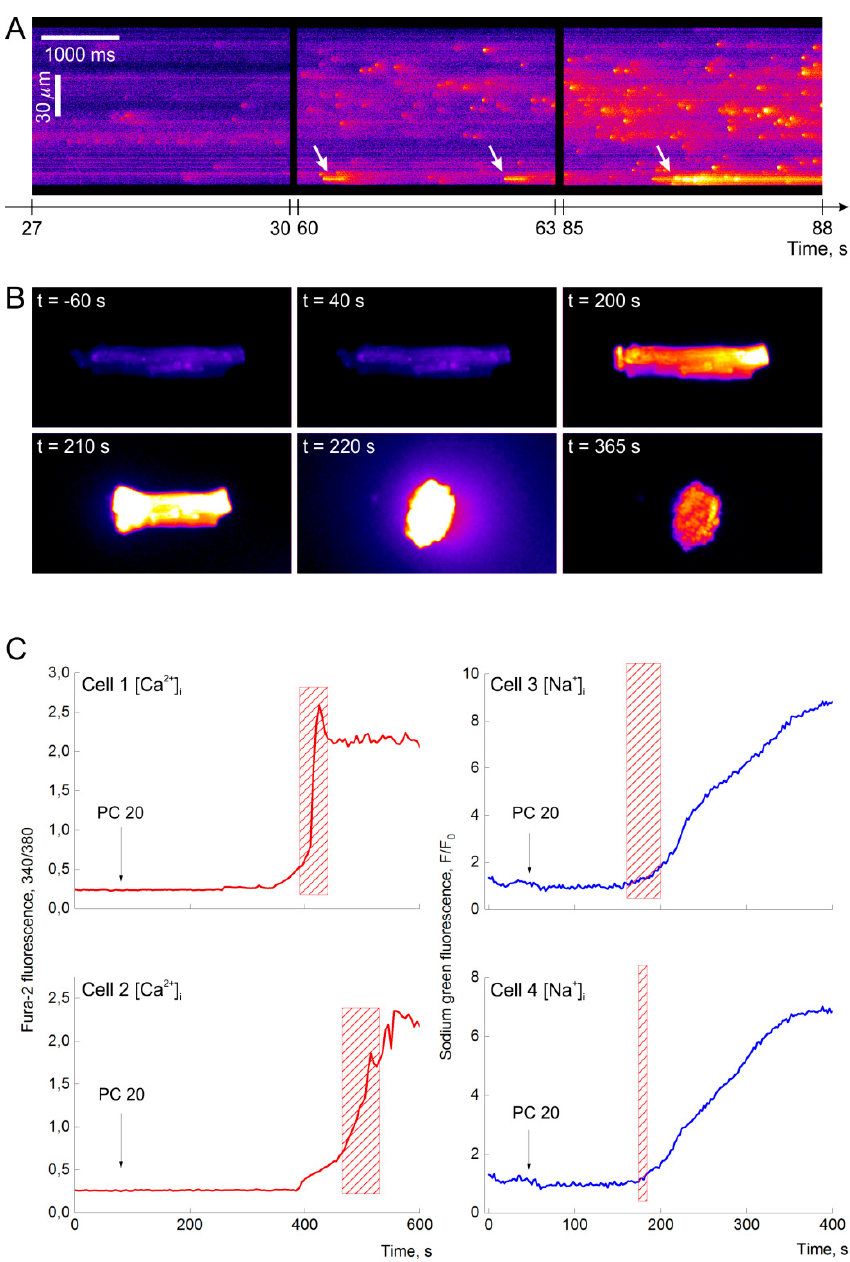
Figure 1. Concentration-dependent effects of PC and MC: Ca 2+ -sparks and Ca 2+ -enriched microdomains, Ca 2+ overload and CM death. Steep rise in [Ca 2+ ] i precedes [Na + ] i increase. ( A ). At low concentration of 5 µM, myristoyl-L-carnitine (MC) induces Ca 2+ -sparks, short and long time living steady state regimes with high [Ca 2+ ] i in isolated microdomains marked by arrows. Confocal images of CM stained with Fluo-4 in XT mode, 27 s (left) and 88 s (right) after the addition of 5 µM MC. Horizontal axis—time; vertical axis—the long axis of the cardiomyocyte. ( B ). At high concentration palmitoyl-L-carnitine (PC, 20 µM) evokes after time delay of approx. 200 s: initial rise of Ca 2+ in limited compartment of the cell (bright spot at right side of cell, t = 200 s), Ca 2+ overload (bright rod shape cell, t = 210 s), hypercontracture and rupture of plasma membrane characterized by fluorescent dye loss (bright oval cell, t = 220 s), and cell death (red oval cell, t = 365). In 700 and 710 s images the fluorescent probe is seen to escape from the cell into the extracellular solution, leading to decrease in signal intensity. ( C ). Steep rise in [Ca 2+ ] i precedes hypercontracture development, while the increment of [Na + ] i follows it. Representative traces of the changes in cytosolic [Ca 2+ ] i (Fura-2, 340/380) and [Na + ] i (Sodium green, F/F 0 ) concentrations throughout the time in 4 cells after the application of 20 µM PC. Red hatched boxes indicate time periods of cell shortening. At the panel, PC 20 means 20 µ M PC. Displayed images and graphs are representative of 3 independent